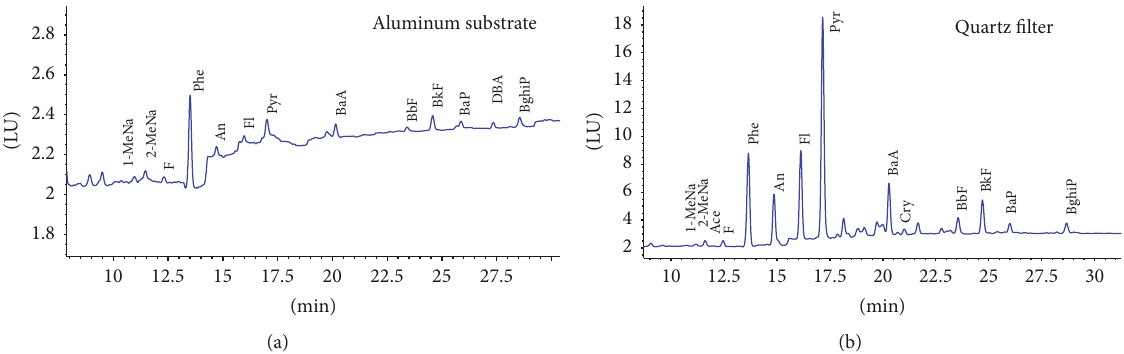
Figure 2: Chromatograms of samples collected on aluminum (a) and quartz (b) substrates at very low concentration levels. The PAH abbreviations are expanded in Reagents and